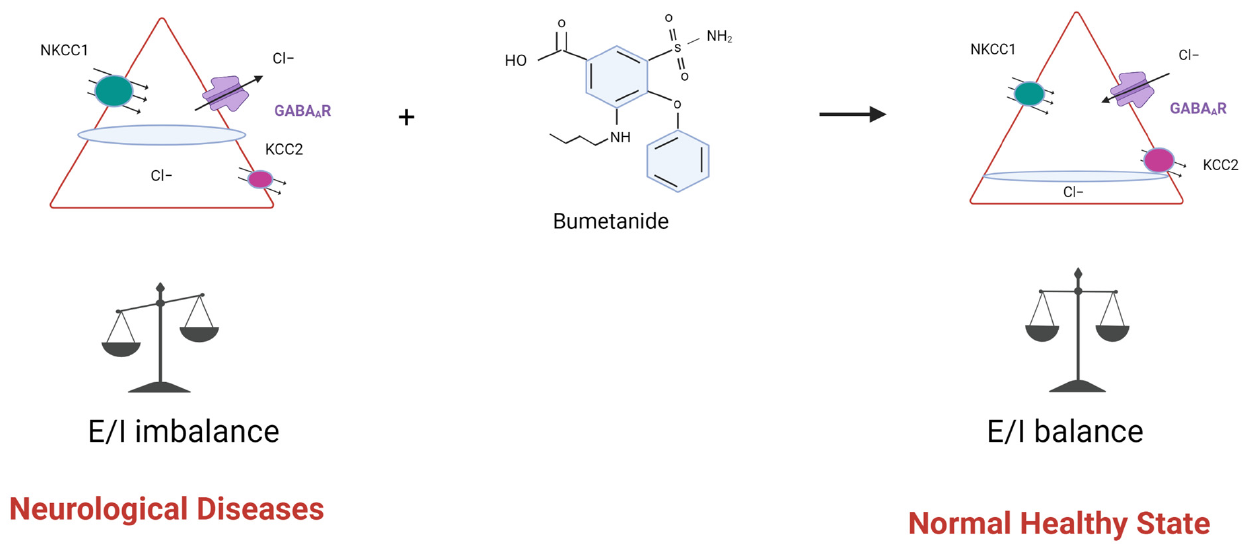
Figure 1. Dysregulation of chloride homeostasis leads to excitatory/inhibitory (E/I) imbalance. An altered expression of KCC2 and NKCC1 in neurological diseases including Alzheimer’s, Huntington’s, and Parkinson’s disease, schizophrenia, Down syndrome and epilepsy could disrupt GABAergic transmission and promote an E/I imbalance. GABA A receptor (GABA A R) activation can shift the response from hyperpolarizing to depolarizing, contributing to enhanced network excitability. This process can be returned to normal by blocking NKCC1 with bumetanide.